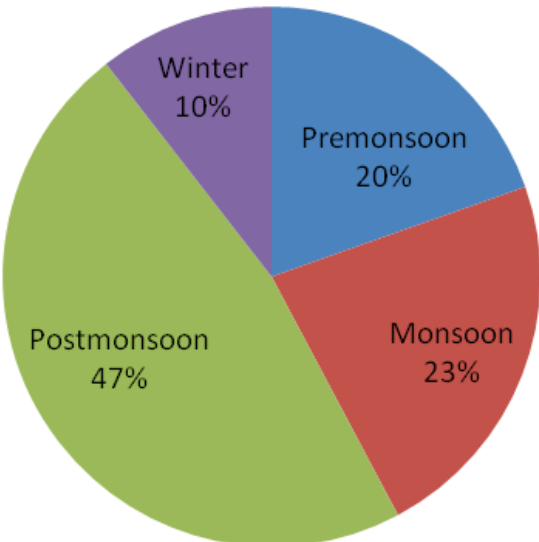
Figure 2. Seasonal variation of Hemiptera population in percentage